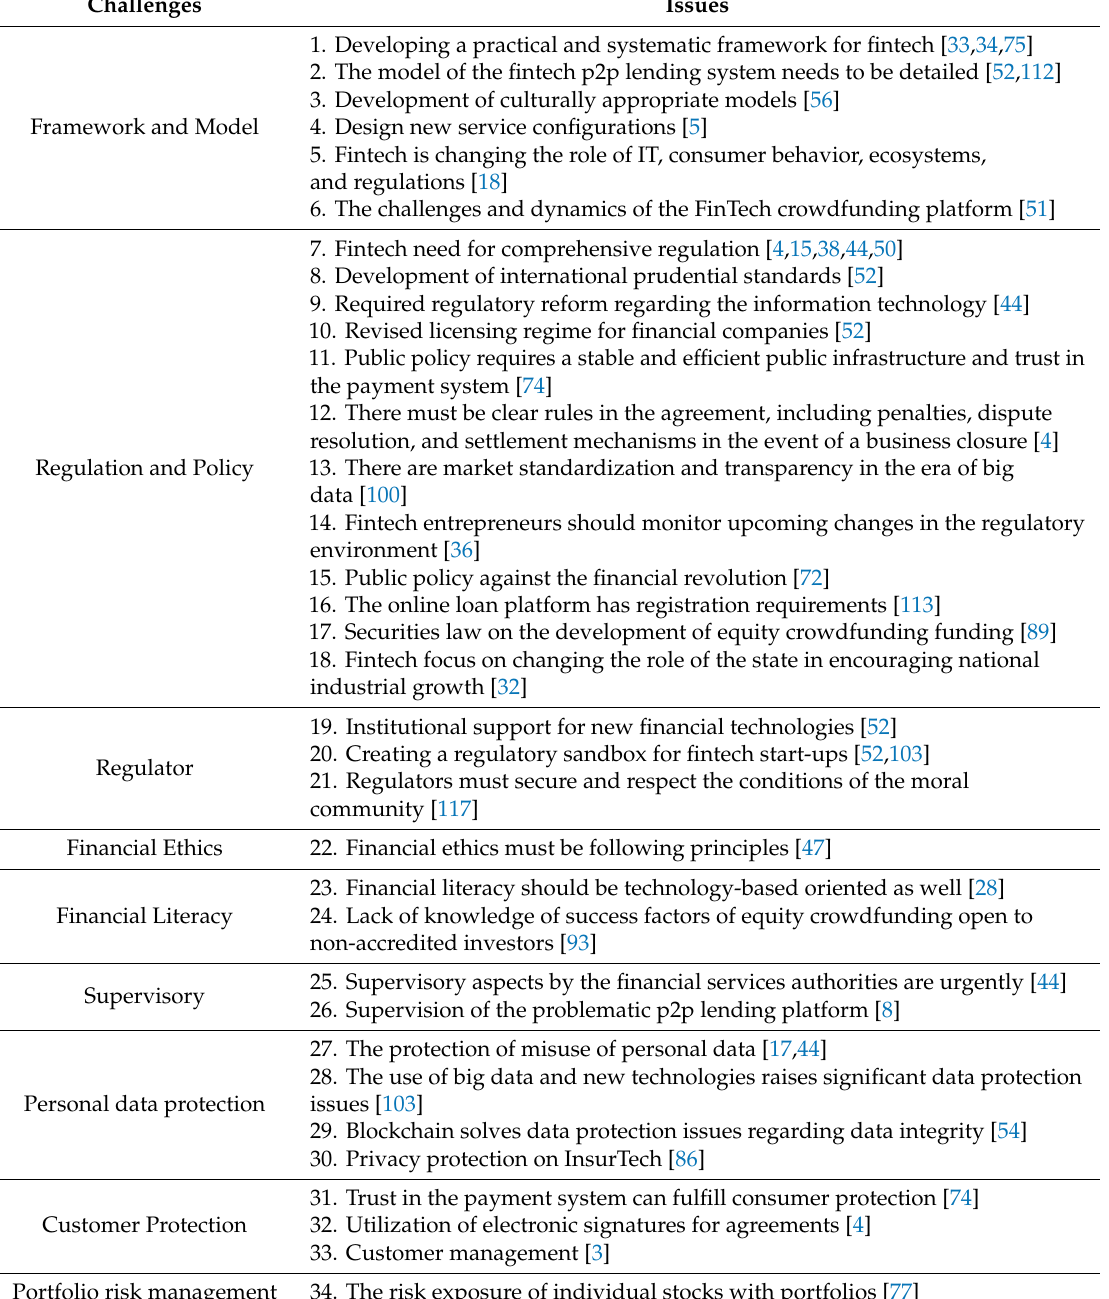
Table 5. Research